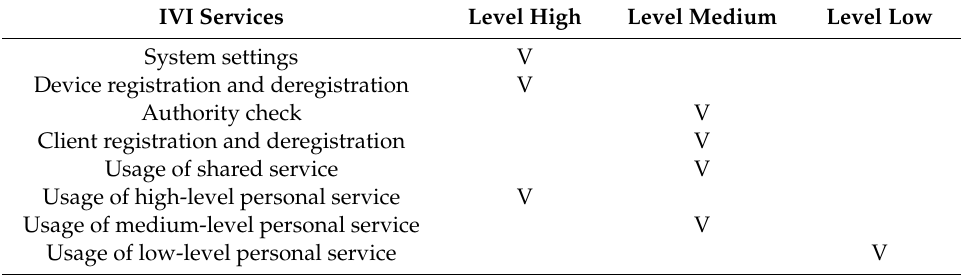
Table 3. A-IVI authority level